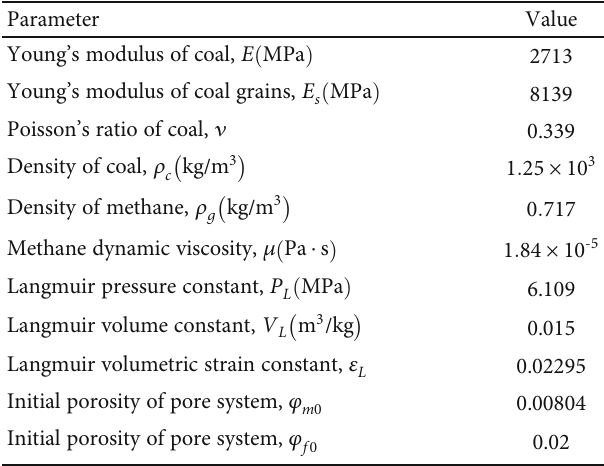
Figure 2: Field data veri fi cation model. Table 1: Parameters of the simulation model.